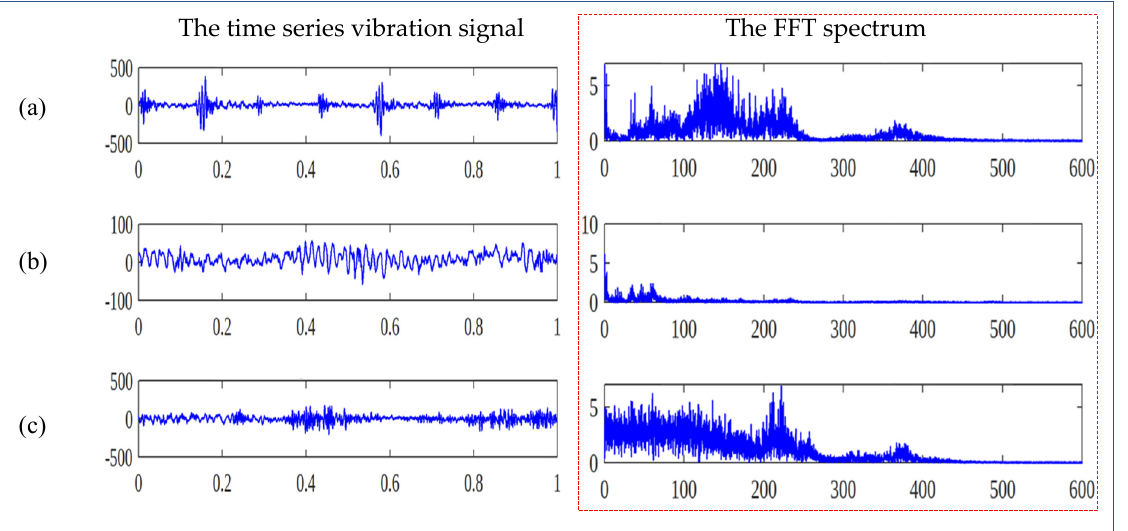
Figure 16. Examples of time series vibration signals and their corresponding FFT spectrum images for ( a ) inner race fault, ( b ) outer race fault, and ( c ) rolling element fault from the bearing vibration data described in Section 2.1.1.